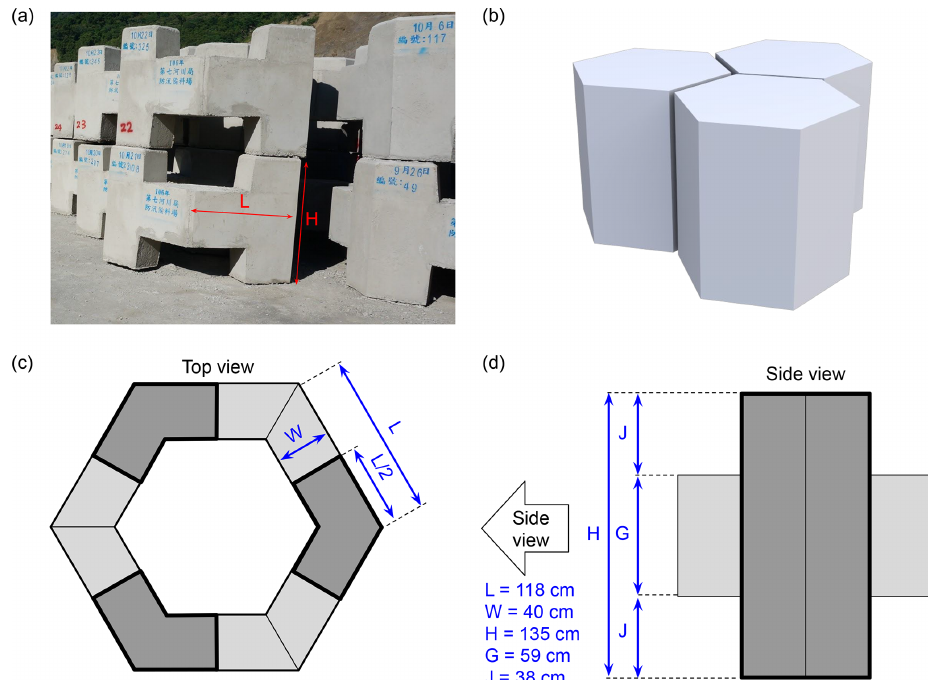
Figure B1. (a) Photograph of the dolosse. (b) 3-D hexagonal shape of the plain dolos as seen by the photogrammetry. (c) Top view of the actual dolos. The dark gray parts are the pillars actually touching the ground and the light gray parts are the “arms” of the dolos. (d) Side view of one dolos element. One dolos consists of three of these parts joined by the